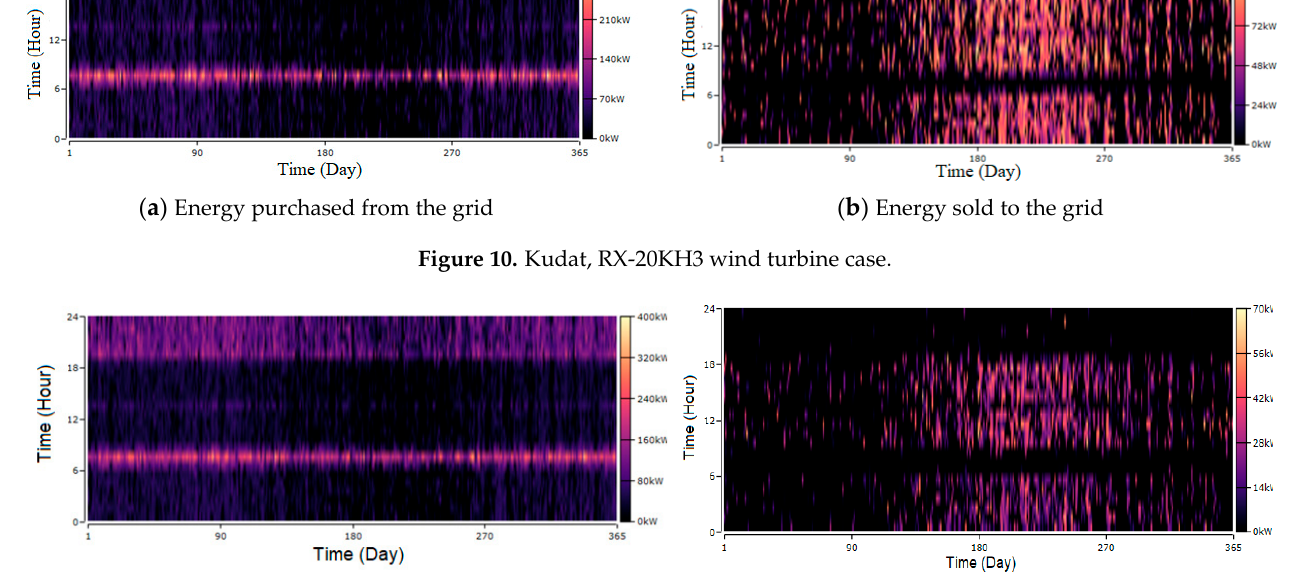
Figure 11. Kudat, WES80 wind turbine case.